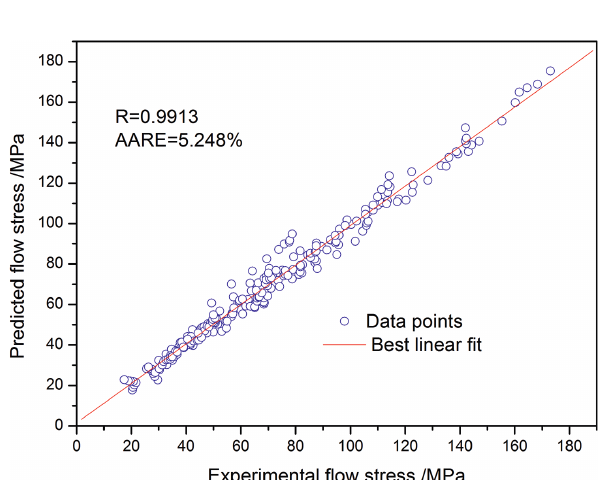
Figure 15: Correlation between the experimental and predicted flow stress